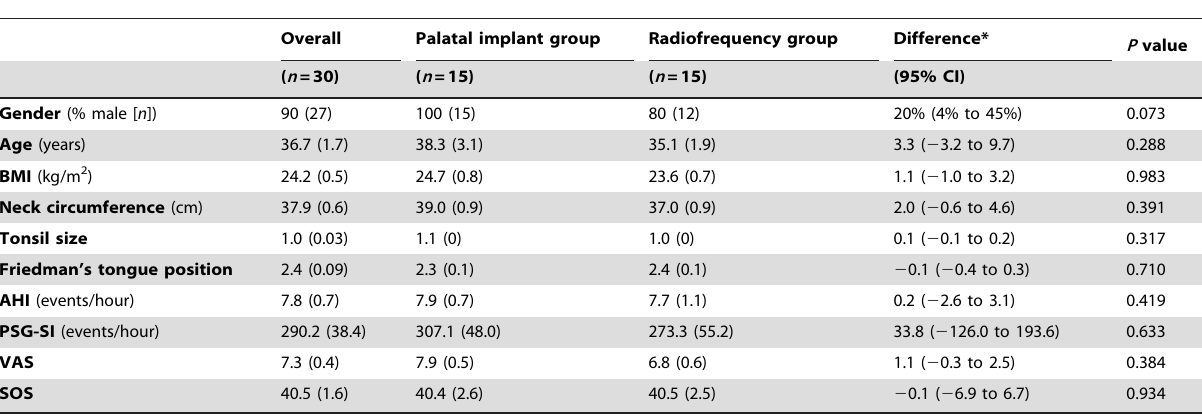
Table 1. Patient characteristics for the entire study cohort ( n =30).